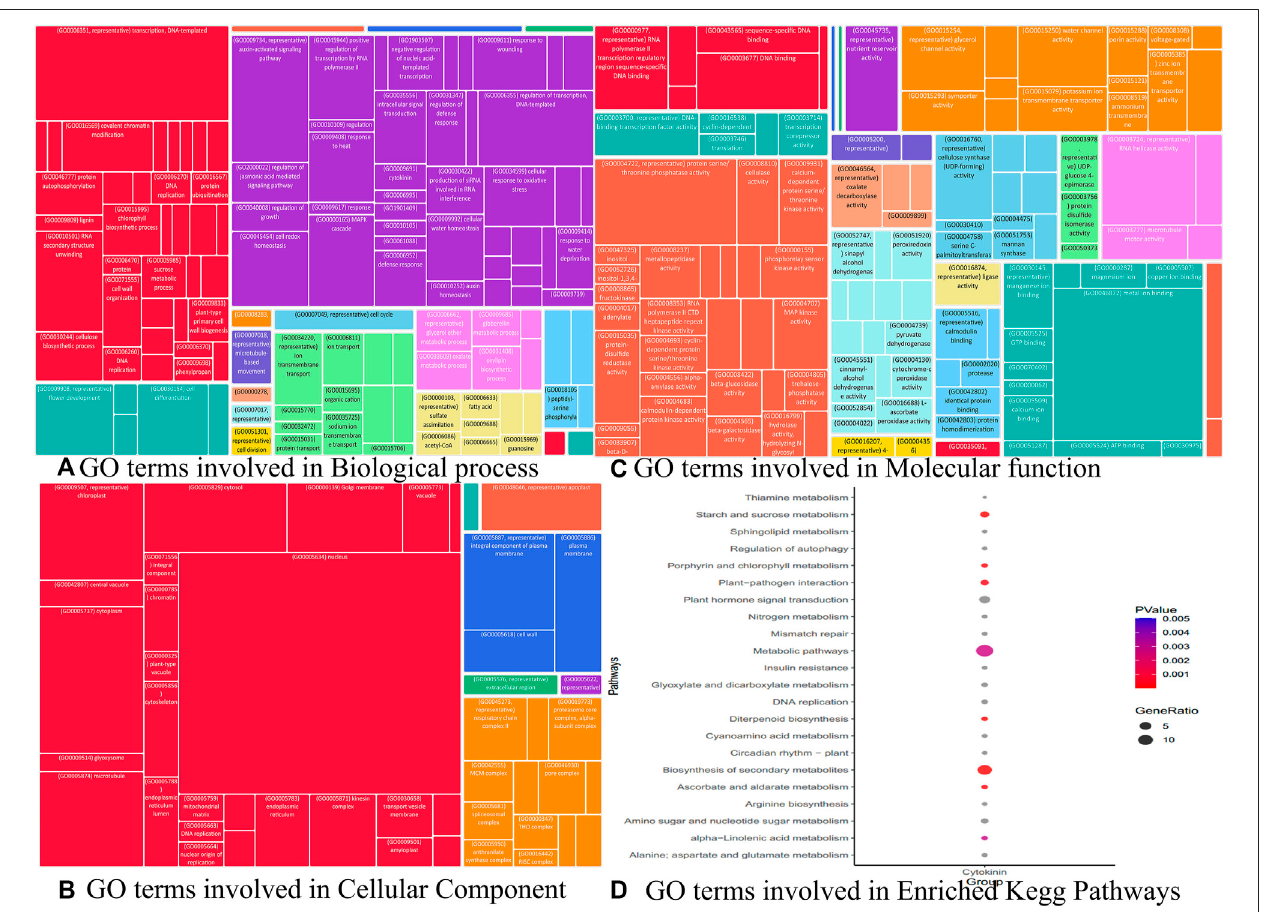
FIGURE 12 | Gene ontology analysis viz biological process, cellular component, and molecular function terms associated with different modules performed using REVIGO.